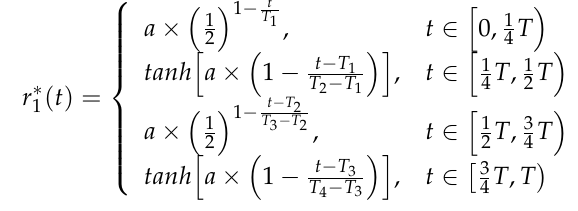
T ) , T 2 = [ 1 T , 1 T ) , T 3 = [ 1 T , 3 T ) , T 4 = [ 3 T , T ] . 4 4 2 2 4 4   ,  =   ,   ,  =   ,   ,  =